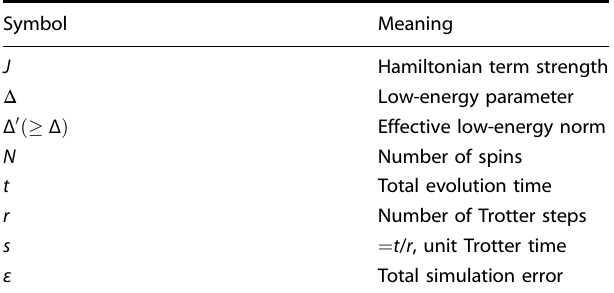
Table 2. Notation: the parameters of the Hamiltonian (local and constant degree) and product formula